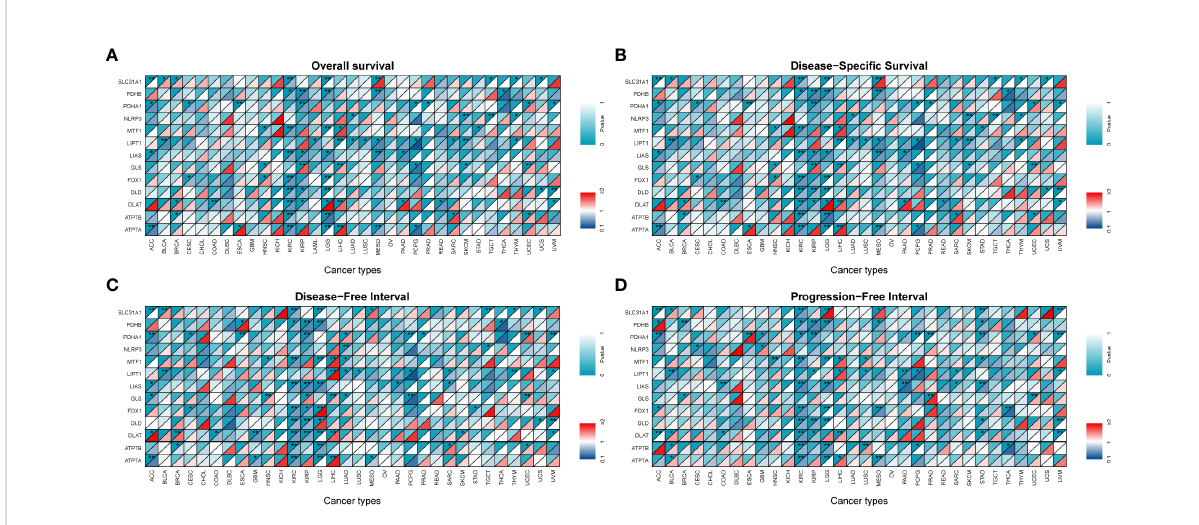
FIGURE 3 Survival analysis and genetic alterations of cuproptosis-related genes. Diagonal split heatmap demonstrating that the expression of cuproptosis- related genes correlates with overall survival (A) , disease-speci fi c survival (B) , disease-free interval (C) , and progression-free interval (D) in patients with different cancer types using univariate Cox proportional hazard regression models. The upper and lower triangles indicate signi fi cance and hazard ratio (HR), respectively. Independent variables with HR of <1 are referred to as protective factors (dark blue area in the bottom right corner), and those with HR of >1 are referred to as risk factors (colored area in the bottom right corner except for dark red), with a threshold speci fi ed as a P-value of <0.05 (*P < 0.05; **P <